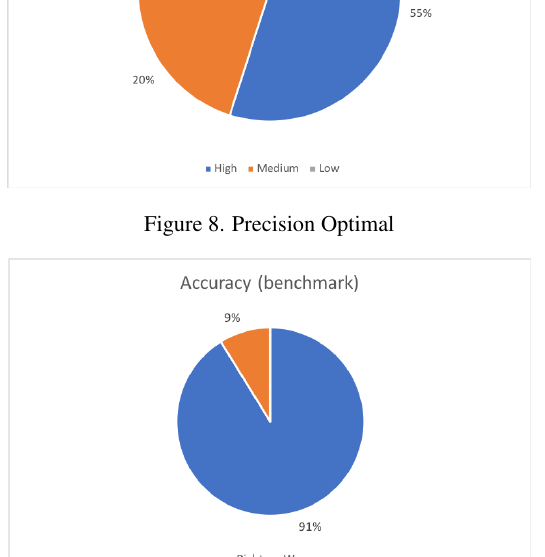
Figure 9. Accuracy Optimal